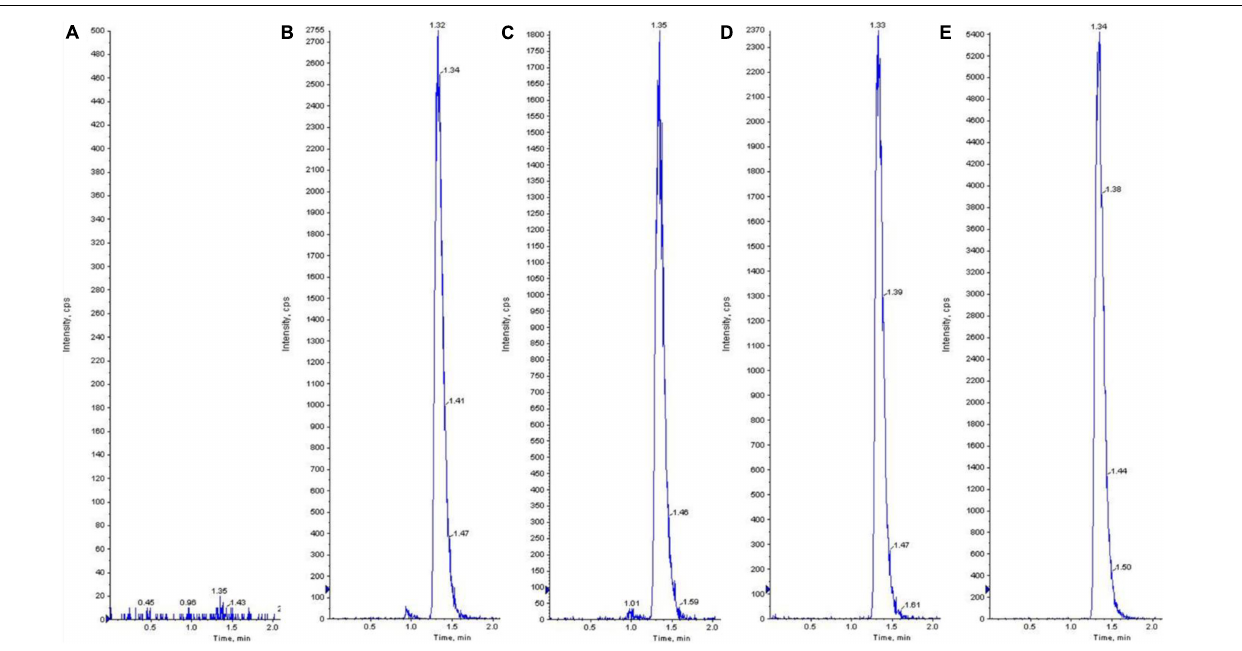
Figure 2 | Determination of the typical chromatograms of sildenafil in rat plasma. (A) The samples of blank plasma. (B) The blank plasma was spiked with standard sildenafil of 100 ng · mL − 1 . (C) The rat plasma 2 h after intragastric administration of sildenafil at low altitude. (D) The rat plasma 2 h after intragastric administration of sildenafil at the high altitude of 2300 m. (E) The rat plasma 2 h after intragastric administration of sildenafil at the high altitude of 4300 m.